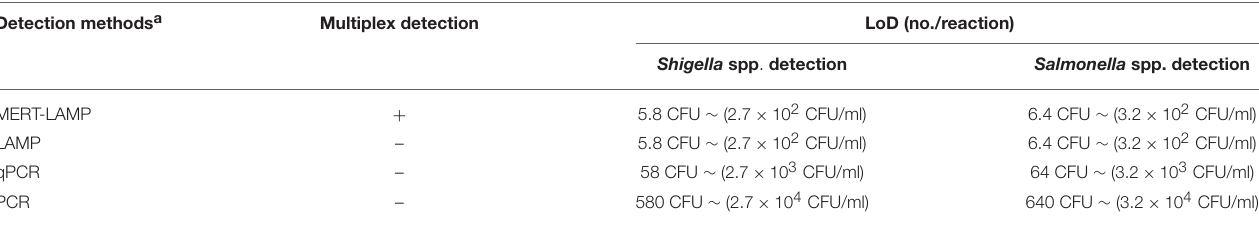
TABLE 4 | Comparison of MERT-LMAP, LAMP, qPCR, and PCR assay for detection of Shigella spp. and Salmonella spp. in artificially contaminated milk samples. Detection methods a Multiplex detection LoD (no./reaction) Shigella spp . detection Salmonella spp.